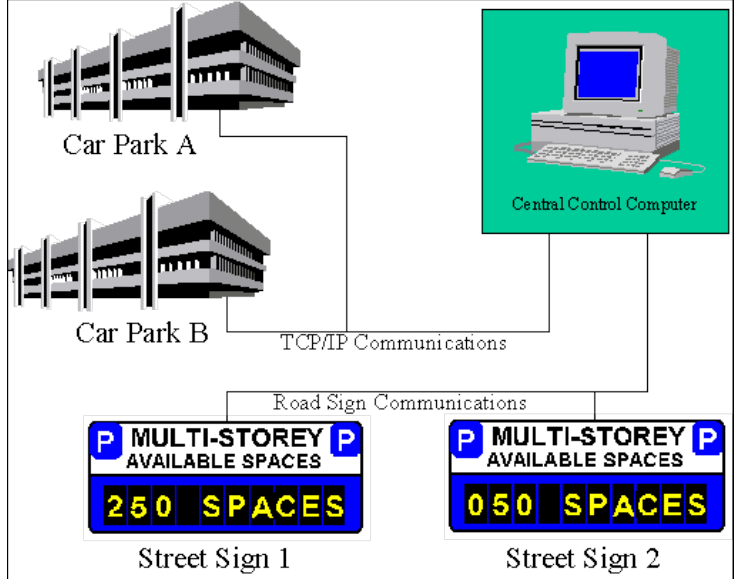
Figure 1. Overview of e-Park System (Tripod, 2018).